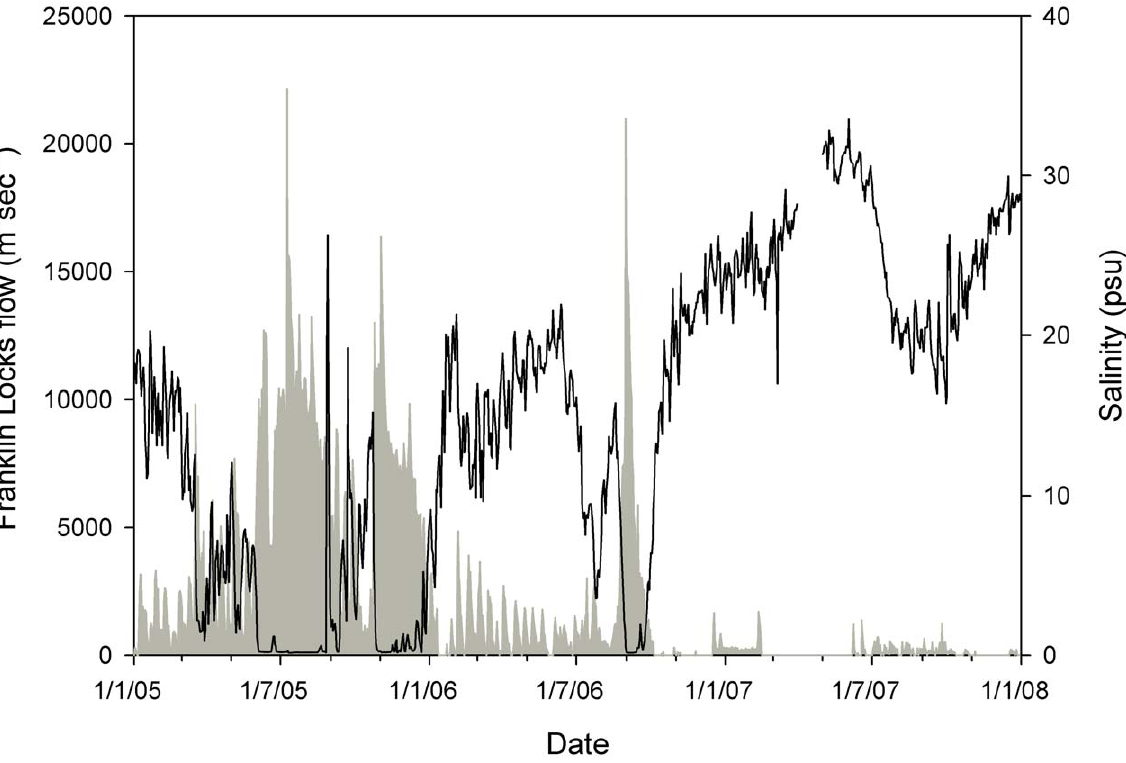
Figure 2. Environmental conditions within the study area. 2005 was a wet year with high freshwater flows through the Franklin Locks (grey shaded area) of long periods with salinity at Cape Coral (black line) below 10 psu. 2006 was a moderately wet year with a short period of high flow, and 2007 was a dry year with very small flows and high salinity.